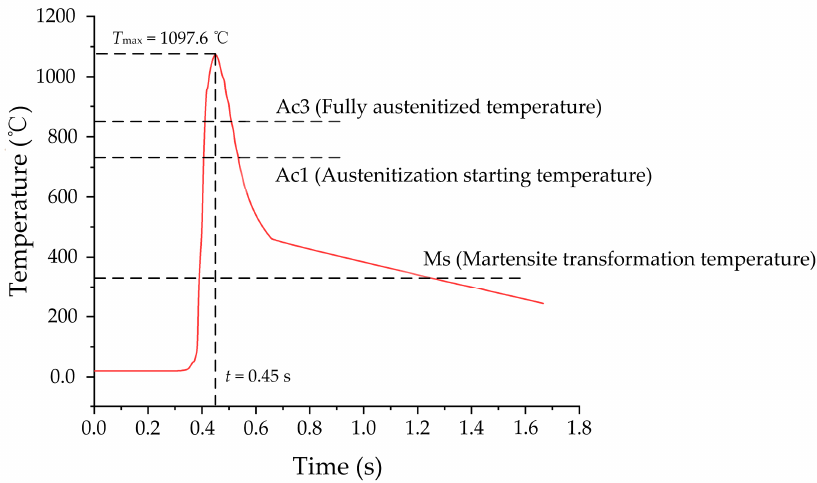
Figure 3. Grinding temperature distribution at different times ( a e = 350 μ m, v w = 9 m/min, v s = 26.4 m/s): ( a ) 0.15 s; ( b ) 0.3 s; and ( c ) 0.45 s.